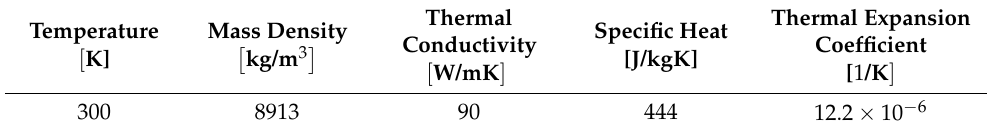
Table 6. Physical properties of the electrodeposited nickel.